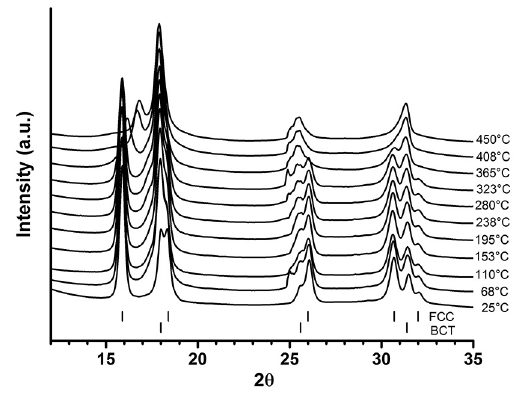
Figure 2: Synchrotron radiation diffraction patterns of hydrided 52Ti-12V-36Cr+4%wt. Zr